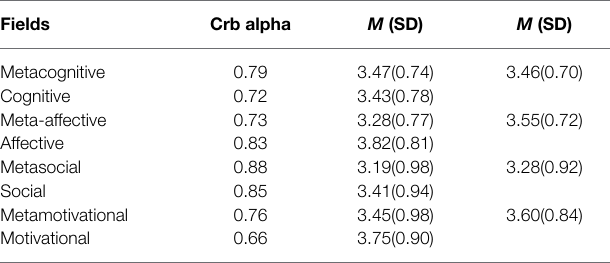
TABLE 1 | Frequency of language learning strategy use in Grade 5. Fields